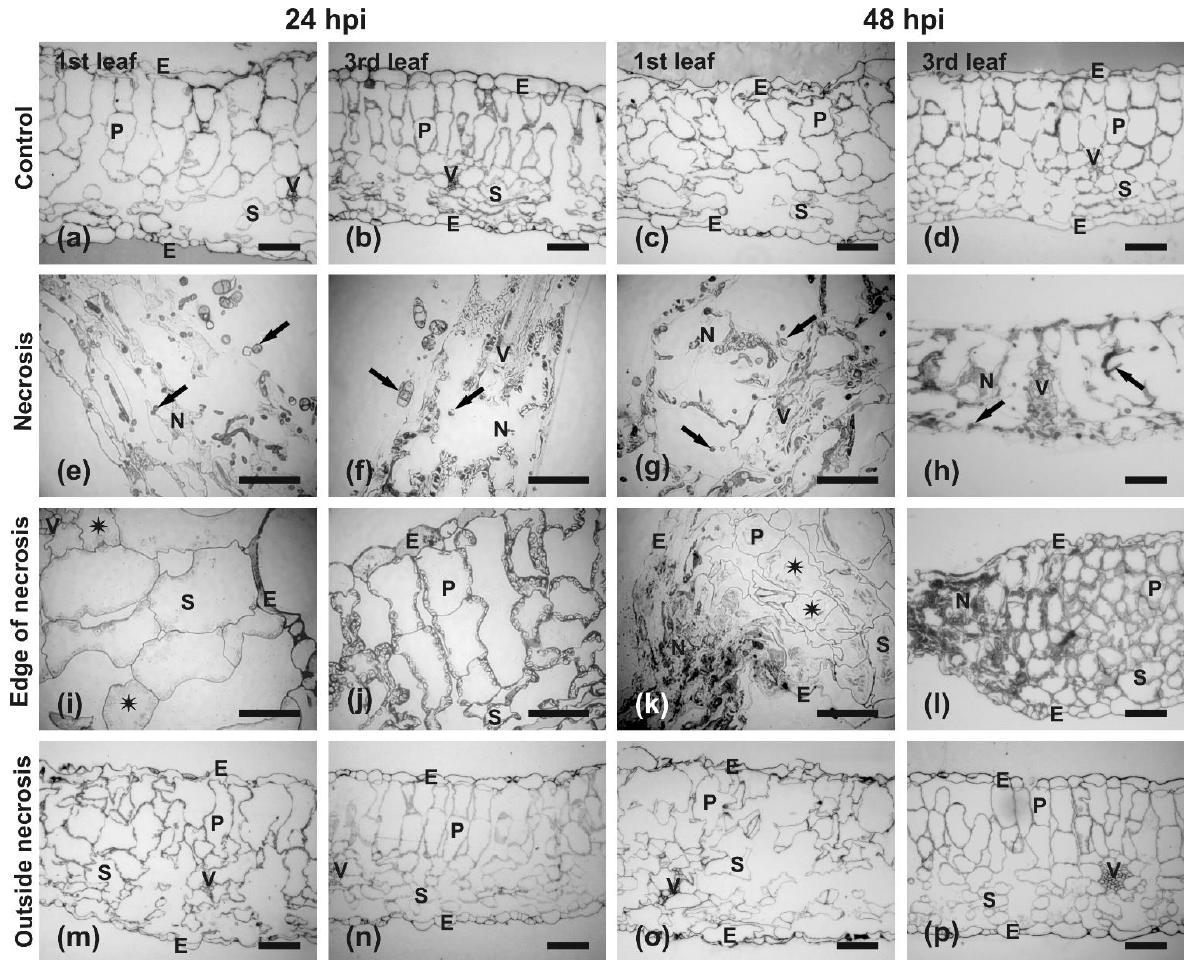
Figure 7. Light microscopy images showing the anatomy of different regions of B. juncea leaves infected with A. brassicicola . Plants were grown under a 16 h day/8 h night photoperiod for 35 days and inoculated with A. brassicicola . The samples were collected from the 1st ( a , c , e , g , i , k , m , o ) and 3rd ( b , d , f , h , j , l , n , p ) leaf at 24 ( a , b , e , f , i , j , m , n ) and 48 hpi ( c , d , g , h , k , l , o , p ). Micrographs of sections taken from uninfected control leaves ( a – d ); necrotized inoculation sites ( e – h ); edge of necrosis ( i – l ; k , ‘green island’ region); and areas outside necrosis ( m – p ; o , chlorosis). Abbreviations: E, epidermis; N, necrosis; P, palisade mesophyll; S, spongy mesophyll; V, vascular bundle. Arrows point to hyphae and asterisks indicate plasmolyzed cells. Scale bars = 10 µm.